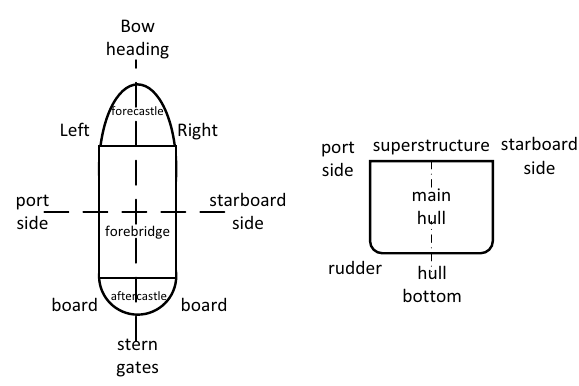
Fig. 5 Basic structure of the ship.